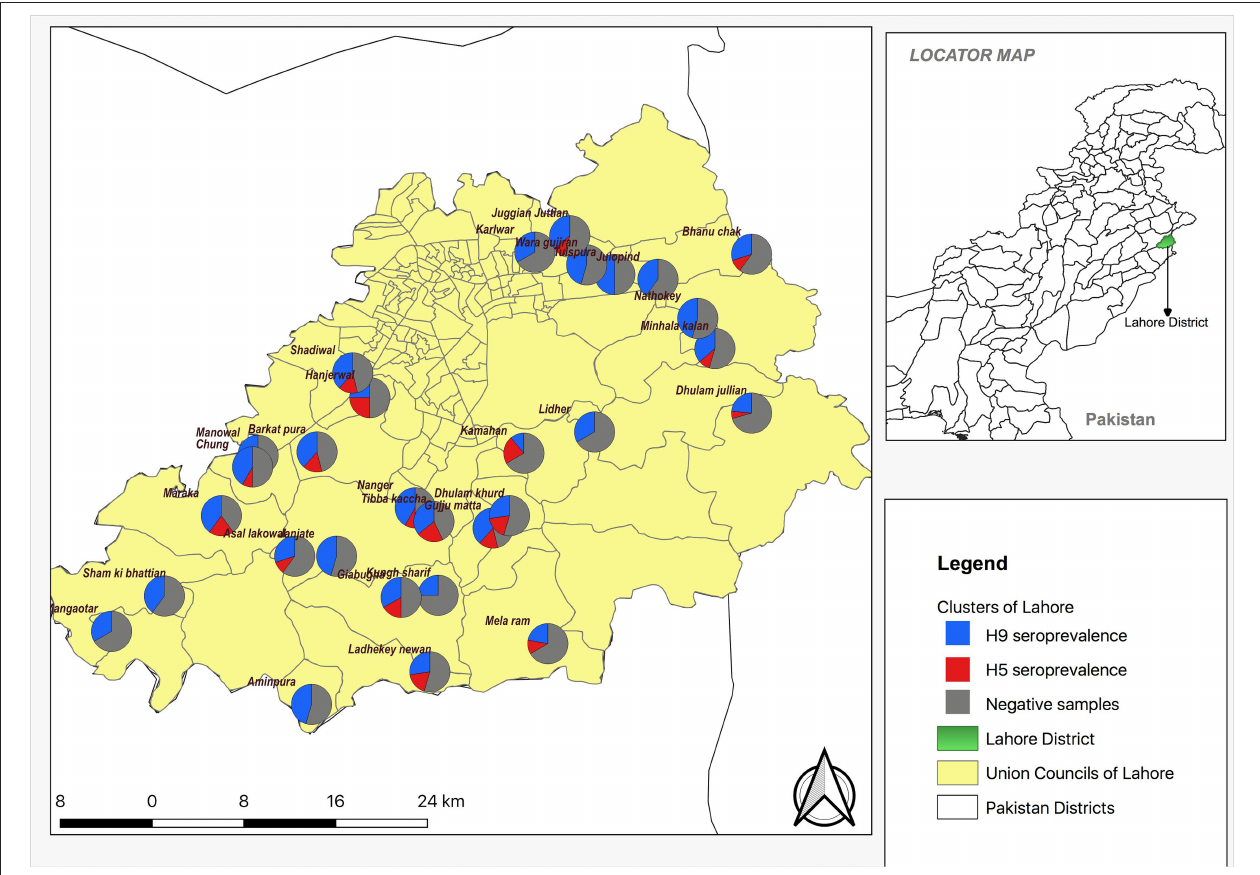
FIGURE 1 | Spatial distribution and village (cluster) level seroprevalence of H9 and H5 in backyard poultry in Lahore district.